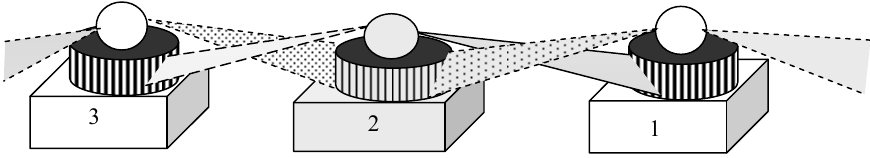
Figure 4. The light identification system.